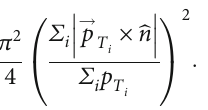
Figure 7: (Color online) χ 2 /NDF for the fi tting of generated p and multiplicity